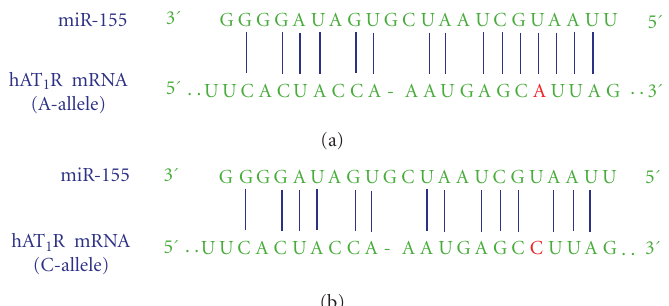
Figure 3: The human AT 1 R +1166 A/C SNP occurs in the miR-155-binding site. (a) Complementarity between miR-155 and the hAT 1 R 3 (cid:3) -UTR site targeted (70–90 bp downstream from the human AT 1 R stop codon). The +1166 A/C SNP corresponds to the nucleotide 86bp downstream from the human AT 1 R stop codon (shown in red print). The binding of miR-155 to the hAT 1 R 3 (cid:3) -UTR target site fulfills the requirement of a 7-bp seed sequence of complementarity at the miRNA 5 (cid:3) end when the +1166 A-allele is expressed. (b) Complementarity between miR-155 and the human AT 1 R 3 (cid:3) -UTR harboring the +1166 C-allele. If the +1166 C-allele is expressed, the seed sequence requirement would not be met and, as a consequence, it would be expected that human AT 1 R expression would be elevated